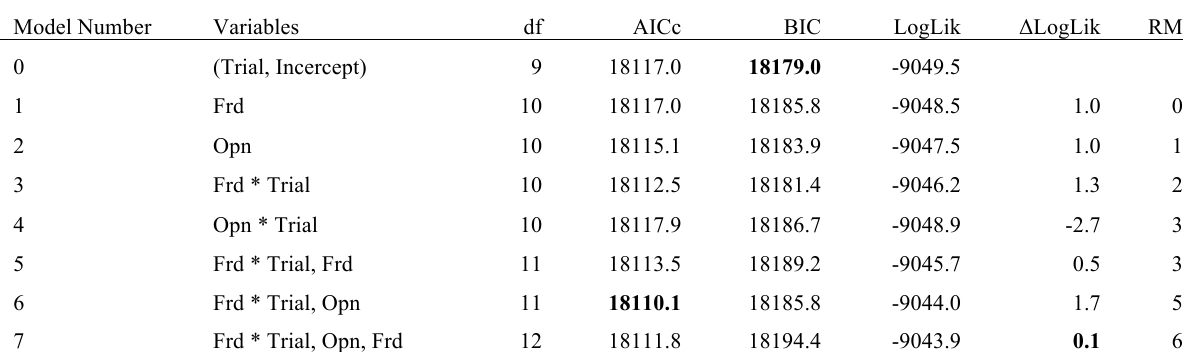
Model Selection Results for Regressions Predicting Transformed Error